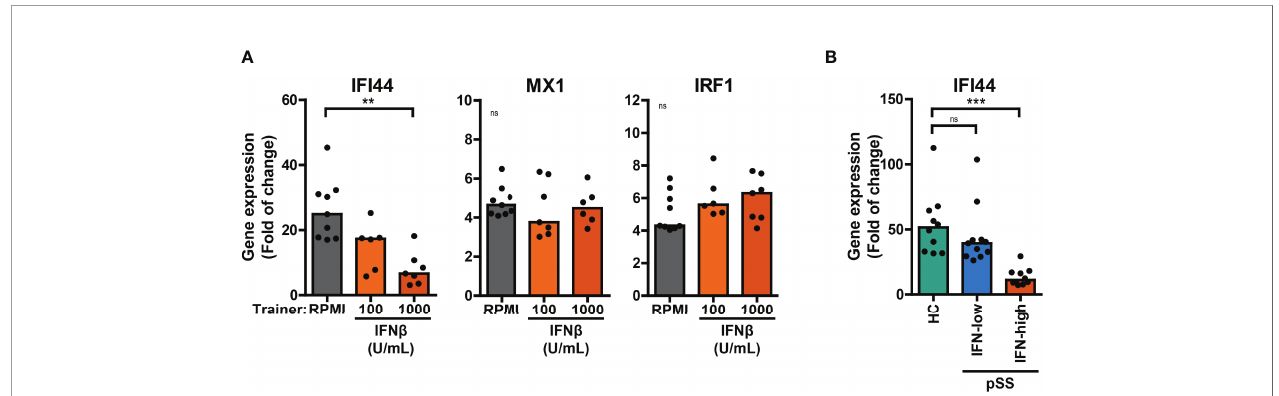
FIGURE 5 | Differential ISG response to type I IFN in IFN b -trained THP-1 and patient ’ s PBMCs. (A) Relative mRNA expression (2 DD CT ) of IFI44 , MX1 and IRF1 in IFN b -trained THP-1 cells re-stimulated with 100 IU/mL IFN b for 4 hours. (B) Relative mRNA expression (2 DD CT ) of IFI44 in PBMCs from pSS strati fi ed based on blood ISG expression and HC stimulated with 100 IU/mL IFN b for 2 hours. Fold change expression was calculated relative to unstimulated cells. Depending on the data distribution, bars represent means or medians and One-way ANOVA or Kruskal-Wallis test were used to compare groups. ns: not signi fi cant, **p<0.01,